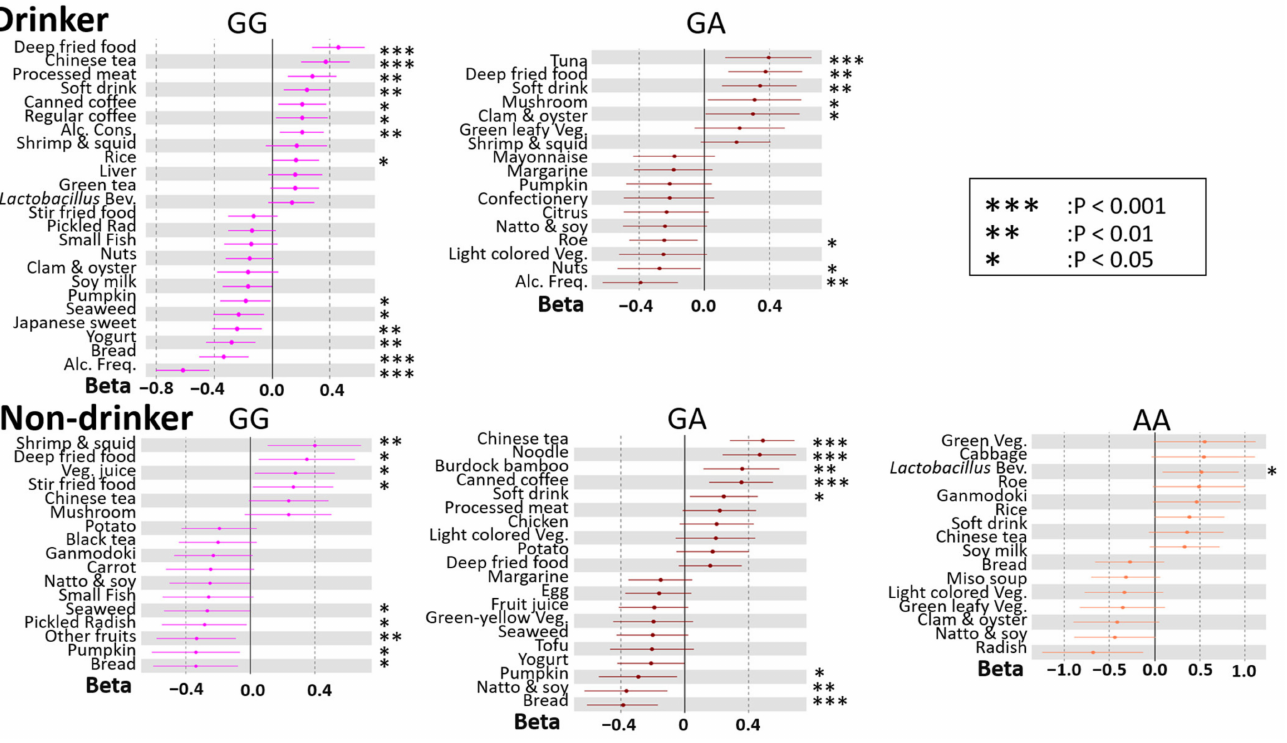
Figure 5. Forest plot showing association between dietary behaviors (DBs) and BMI for each rs671 genotype in females. The X -axis and Y -axis show the standardized beta coefficient ± standard deviation and each DB, respectively. Pink, blown, and beige spots indicate the results for GG, GA, and AA types of rs671 genotypes, respectively. Alc. Cons, alcohol consumption; Alc. Freq., alcohol frequency; Lactobacillus Bev., Lactobacillus beverage; Light colored Veg., light-colored vegetable. Asterisks indicate statistical significance for heterogeneity (***, p < 0.001; **, p < 0.01; *, p <